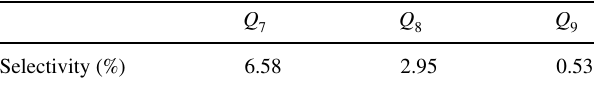
Table 4 Selectivity of Q 1 – Q 9